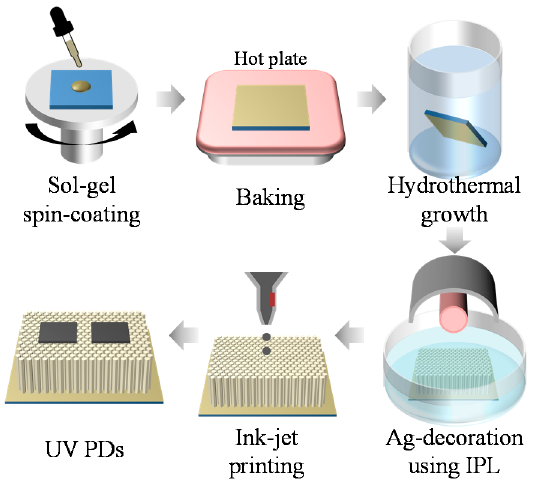
Figure 1. Schematic of fabrication for the Ag-decorated ZnO NW UV